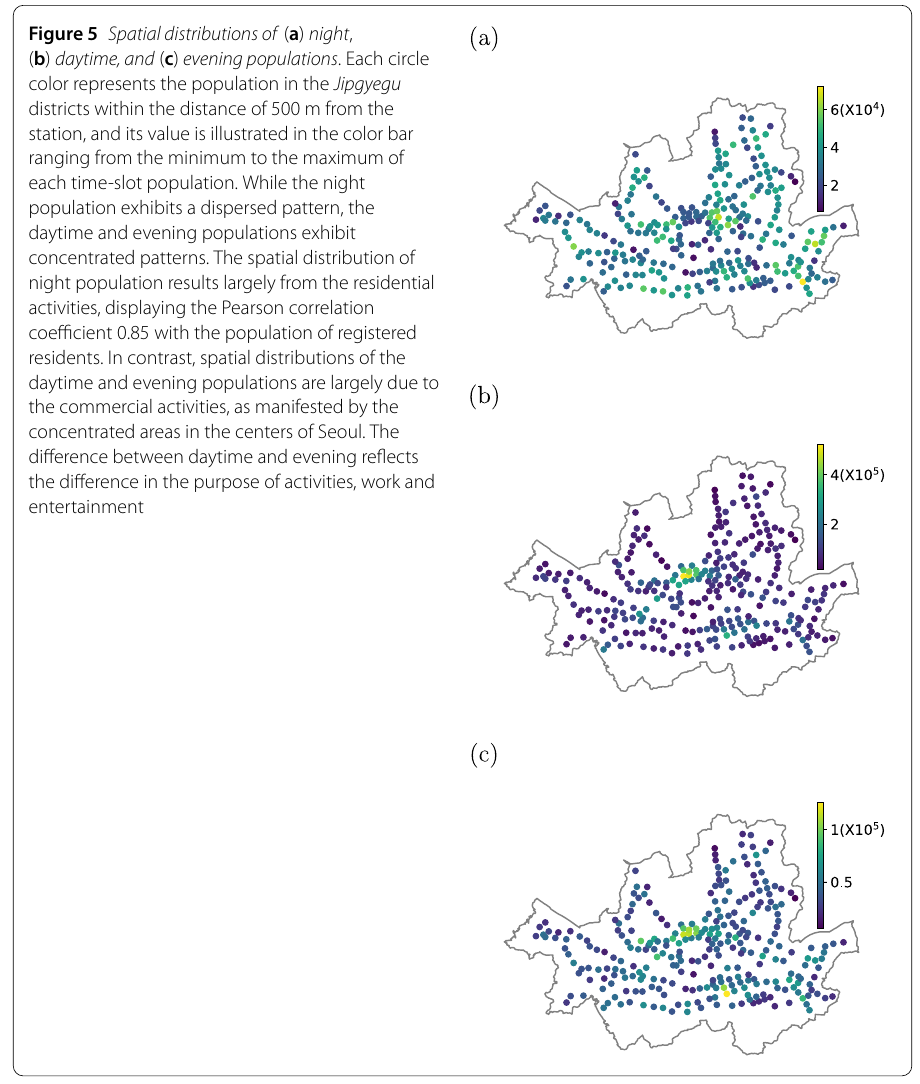
Figure 5 Spatialdistributionsof ( a ) night , ( b ) daytime,and ( c ) eveningpopulations . Each circle color represents the population in the Jipgyegu districts within the distance of 500 m from the station, and its value is illustrated in the color bar ranging from the minimum to the maximum of each time-slot population. While the night population exhibits a dispersed pattern, the daytime and evening populations exhibit concentrated patterns. The spatial distribution of night population results largely from the residential activities, displaying the Pearson correlation coefficient 0.85 with the population of registered residents. In contrast, spatial distributions of the daytime and evening populations are largely due to the commercial activities, as manifested by the concentrated areas in the centers of Seoul. The difference between daytime and evening reflects the difference in the purpose of activities, work and